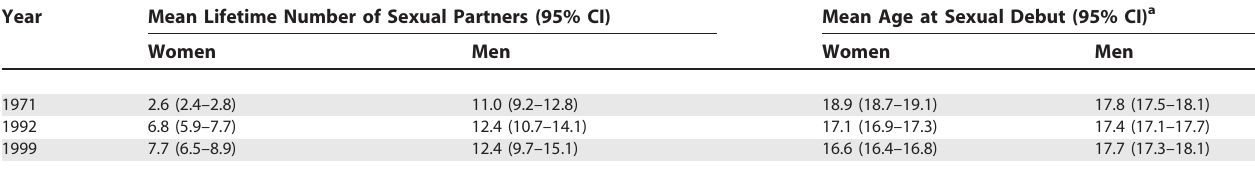
Table 1. Finnish Patterns of Sexual Behaviour over Time